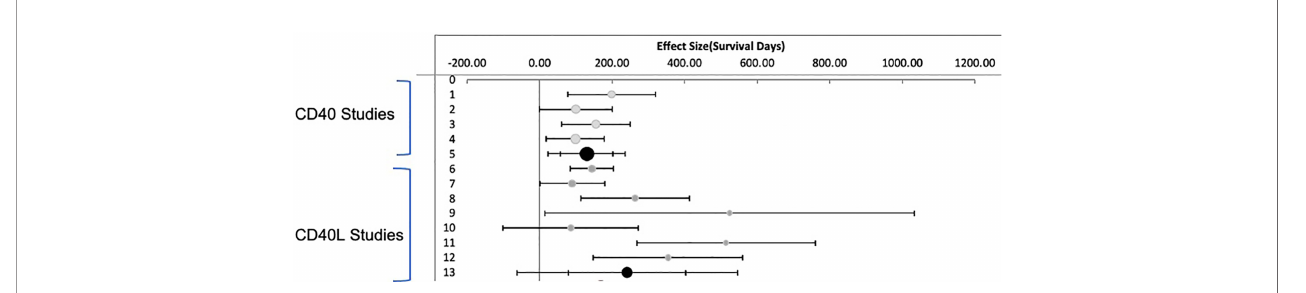
FIGURE 3 | Meta Analysis: Inverse Variance Weighting Random Effects Model. Published studies of anti CD40 and anti CD154 antibodies in nonhuman primates. Forest plot displaying random effects meta-analysis results of the association compared to nontreated animals. The Black circle is the mean values for treatment effect across all studies. Light Grey circles are anti CD40. Dark Grey circles are anti CD154.